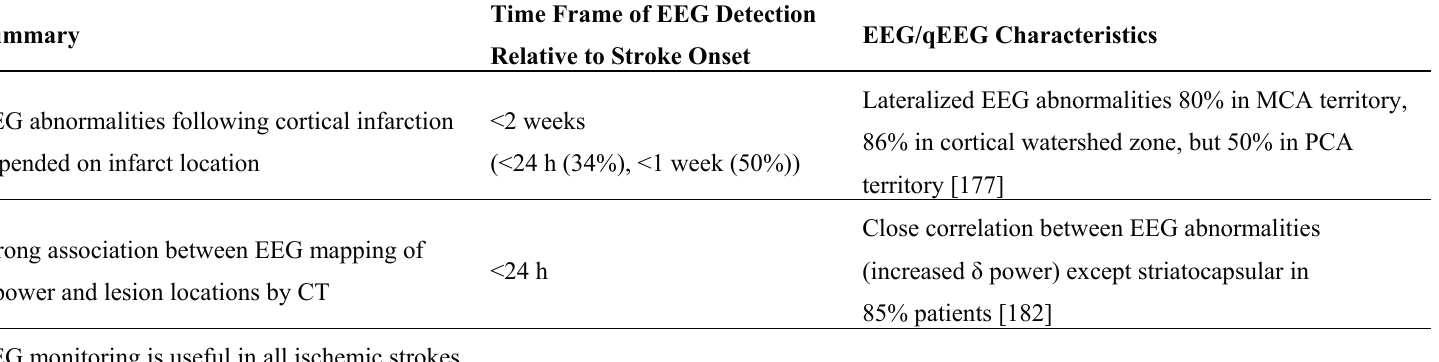
Table 2. EEG characteristics in various locations and subtypes of ischemic